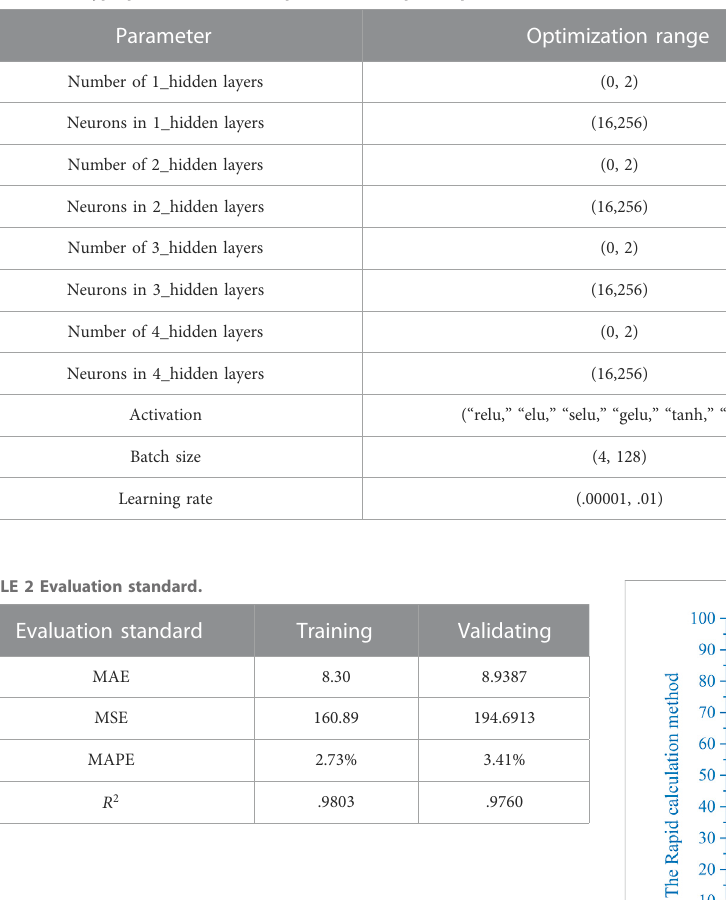
TABLE 1 DNN hyperparameters search space and the optimal parameters.